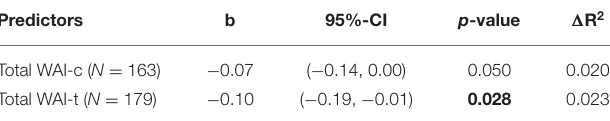
TABLE 3 | Results from two separate linear regression models predicting post-treatment OCD severity from therapeutic alliance (from patient and therapeutic perspective) adjusted for baseline OCD severity and for group membership of the RCT. Predictors